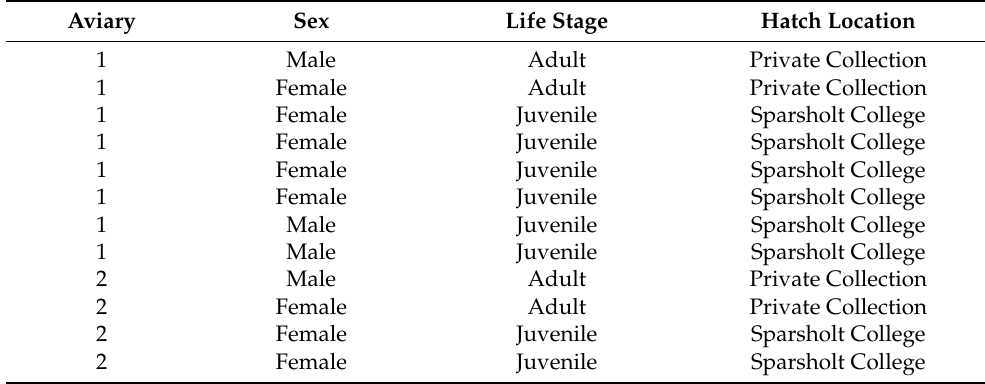
Table 1. Age and sex of study subjects.